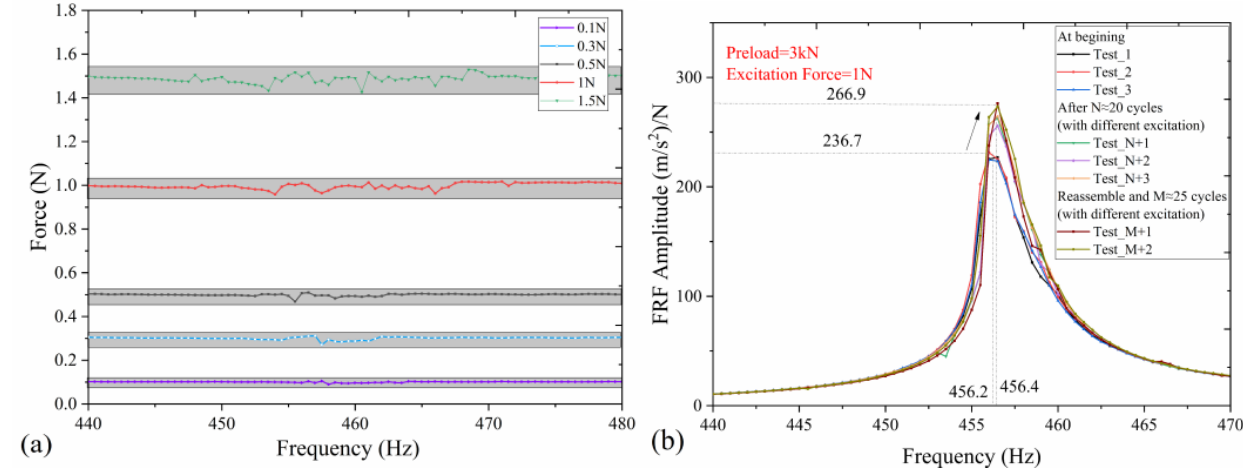
Figure 12. Verification of testing results, ( a ) the controlled force amplitude for the selected frequency range, ( b ) repeatability check of the FRF measurements.